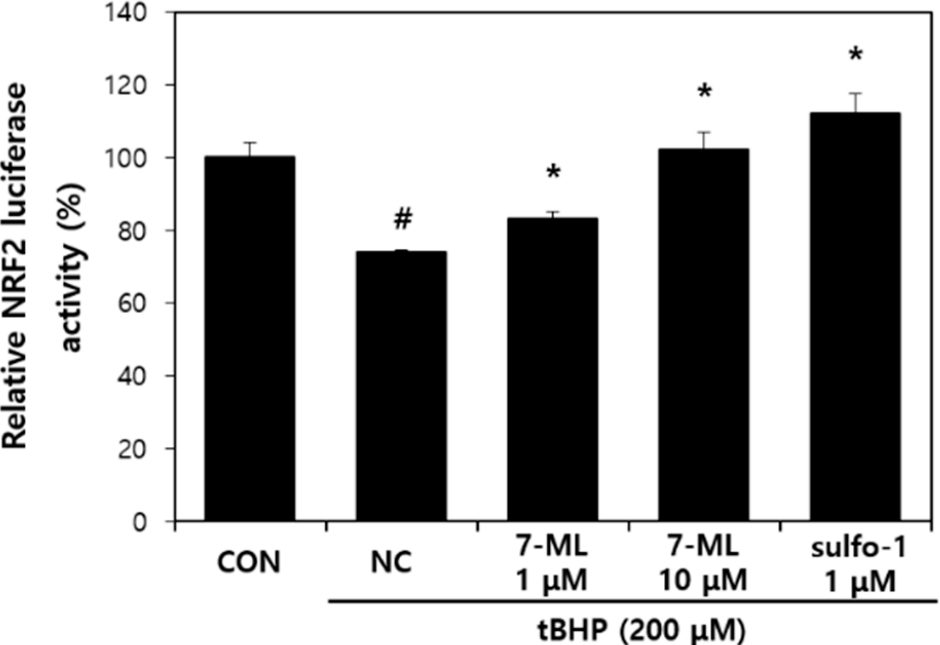
Figure 2. Effect of 7-ML on Nrf2 transactivation. The pGL3-Basic-ARE plasmid was transiently transfected into HepG2 cells and treated with 7-ML for 20 h after transfected, and tBHP (200 µ M) with 7-ML was further treated for 2 h, after which luciferase activity was measured. Luciferase activities were normalized versus nontreated controls. Results are expressed as means ± SDs ( n = 3). # p < 0.05 vs. nontreated cells; * p < 0.05 vs. the tBHP-treated controls. CON, nontreated control; NC,